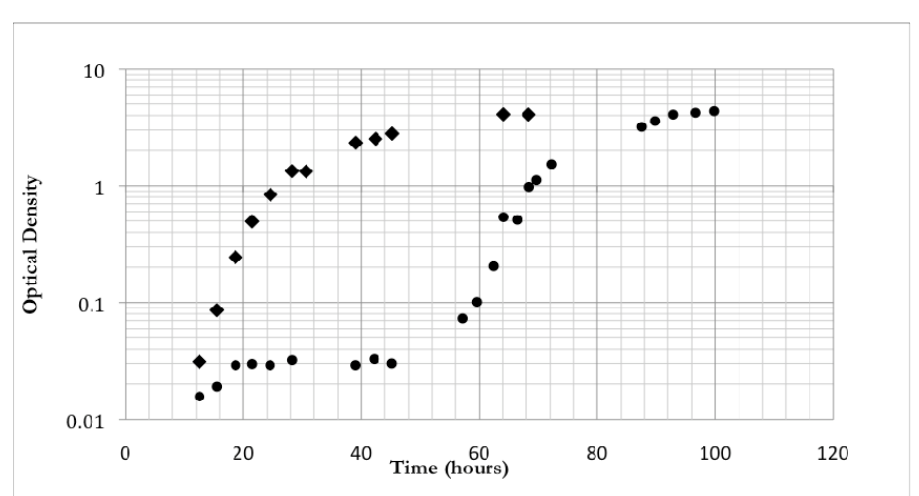
Figure 2. Optical density growth curves over time of non-spray dried M. smegmatis (  ) and multiply cycled M. smegmatis (  ).